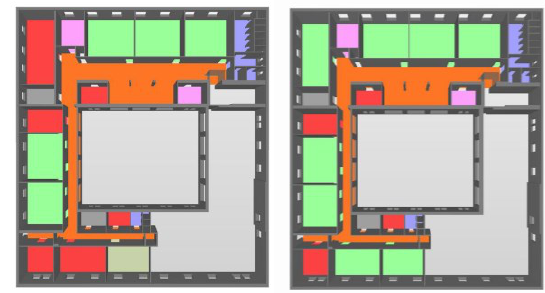
Figure 5. Change of the premises' use destination on the second floor. In green the classrooms and in red the additional educational spaces.